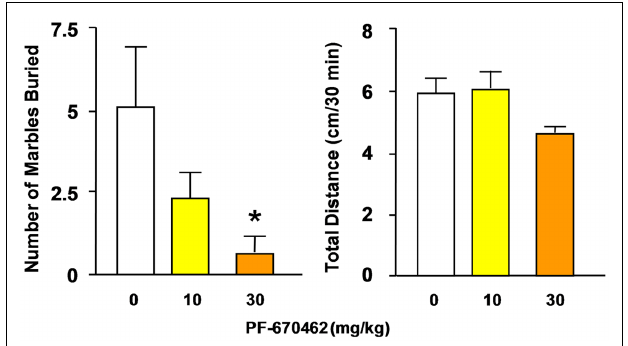
FIGURE 5 |The CK1 ε inhibitor PF-670462 shows anxiolytic activity in the marble burying test with a strong yet non-significant trend at 10mg/kg and a significant effect at 30mg/kg, consistent with the dose–response anxiolytic signature uncovered by the high-throughput screen [ANOVA F (4,43) > 8.8, p < 0.0001; Fisher PLSD p < 0.02]. The drug was injected s.c. 15min before the 30-min test.There were no significant effects on